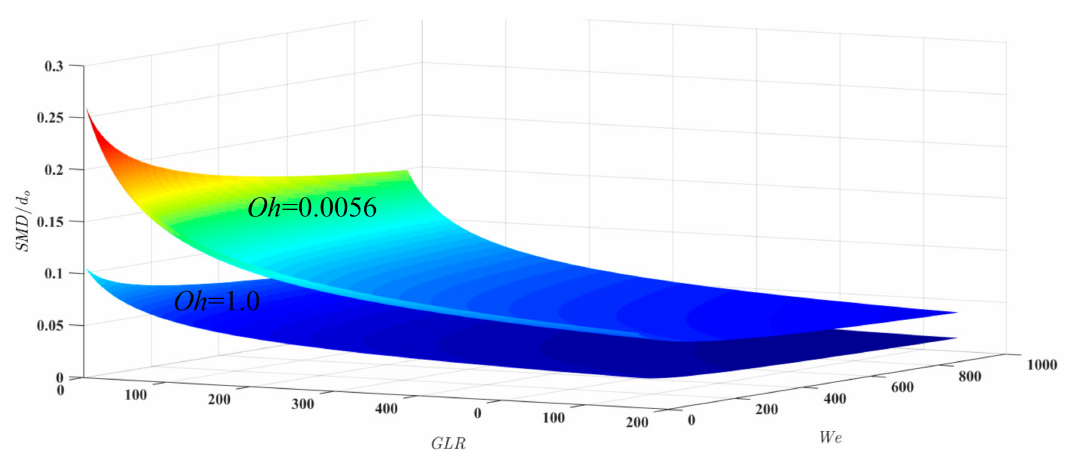
Figure 9. Three-dimensional response plot of SMD / d o as a function of We and GLR for Oh = 0.0056 and Oh = 1 at x / dg ~30.